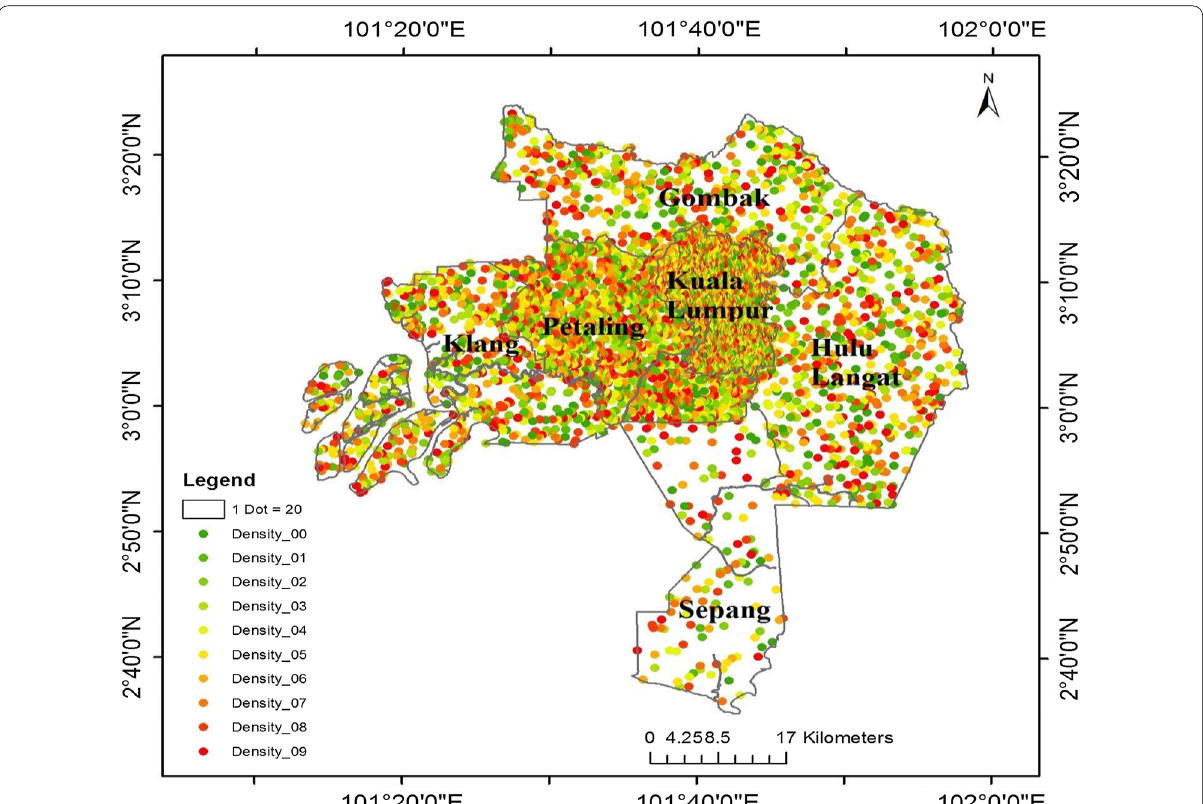
Fig. 4 Spatial distribution of population density in six districts of the Klang Valley: Klang, Petaling, Kuala Lumpur, Gombak, Hulu Langat and Sepang from 2000 to